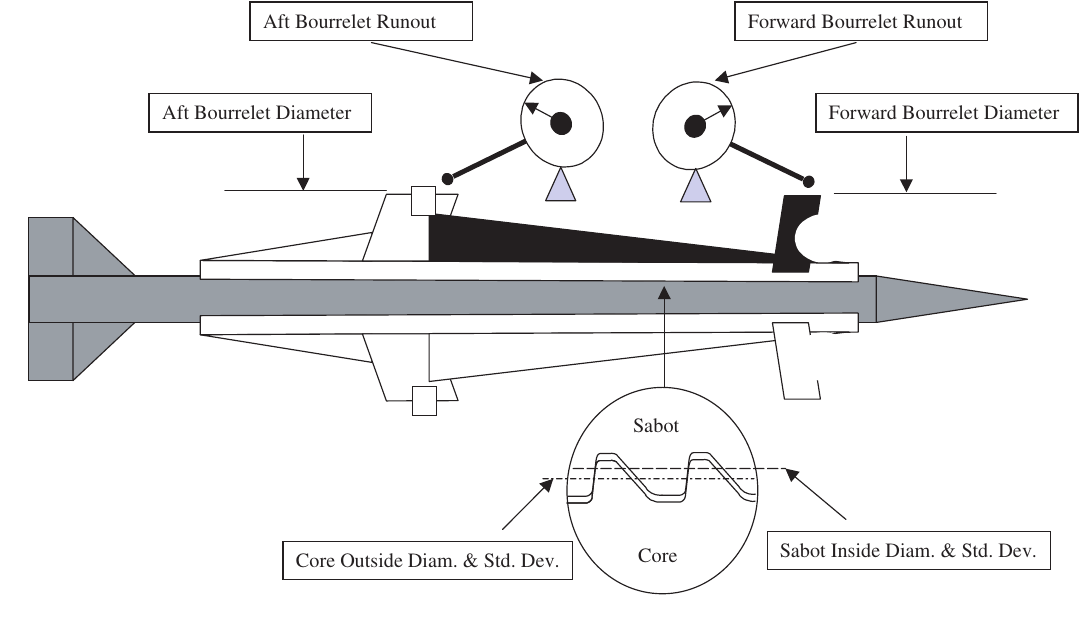
Fig. 3. Balloting analysis variables.